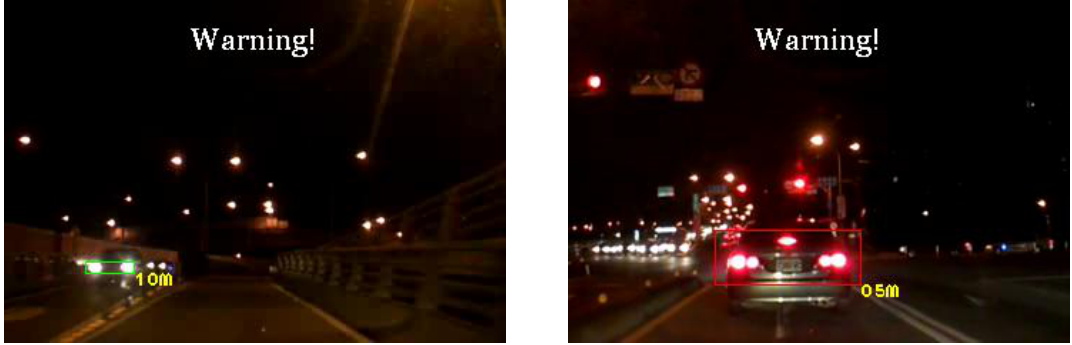
Figure 24. Results of vehicle detection and event determination for a nighttime highway under normal illumination and slightly congested traffic conditions (Test video 8).